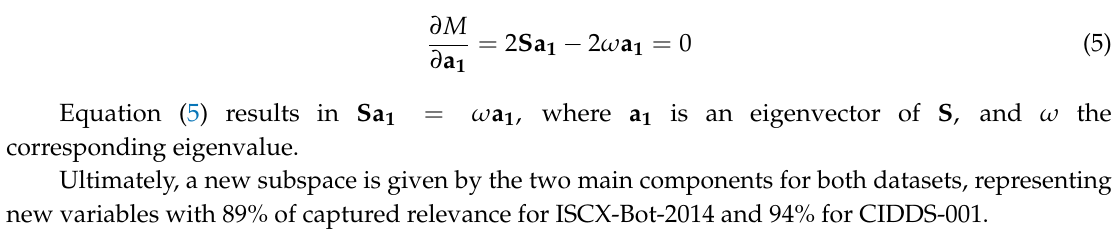
Table 5 indicates used hyperparameters λ in algorithm portfolio A and their corresponding